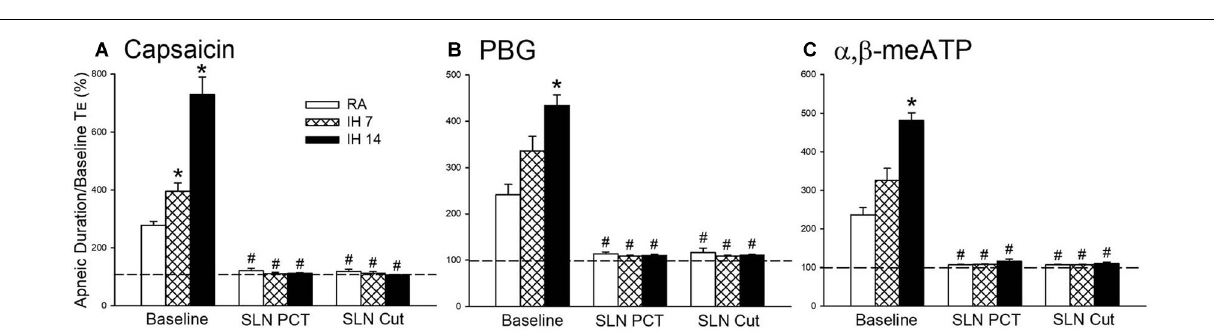
FIGURE 2 | Mean apneic responses to laryngeal provocation of capsaicin (A) , phenylbiguanide (PBG; B ), and α , β -methylene-ATP ( α , β -meATP; C ) from three study groups after exposure to room air (RA), intermittent hypoxia (IH) for 7 (IH7), or 14 days (IH14). The responses to provocation of each stimulant were measured before, during perineural capsaicin treatment (PCT) of superior laryngeal nerves (SLNs), and after bilateral section of SLNs (SLNs Cut). Capsaicin, PBG, and α , β -meATP were locally applied to the larynx. Apneic responses are reflected using the apneic ratio, which is defined as the longest expiratory duration ( T E) occurring during the first 10 breaths after the provocation divided by the baseline T E. Horizontal dashed lines indicate an apneic ratio of 1 (100%; no response). * p < 0.05 compared with RA; # p < 0.05 compared with baseline responses in the same group. Data in each group are the mean ± SE from 10 rats. See the legend in Figure 1 for further